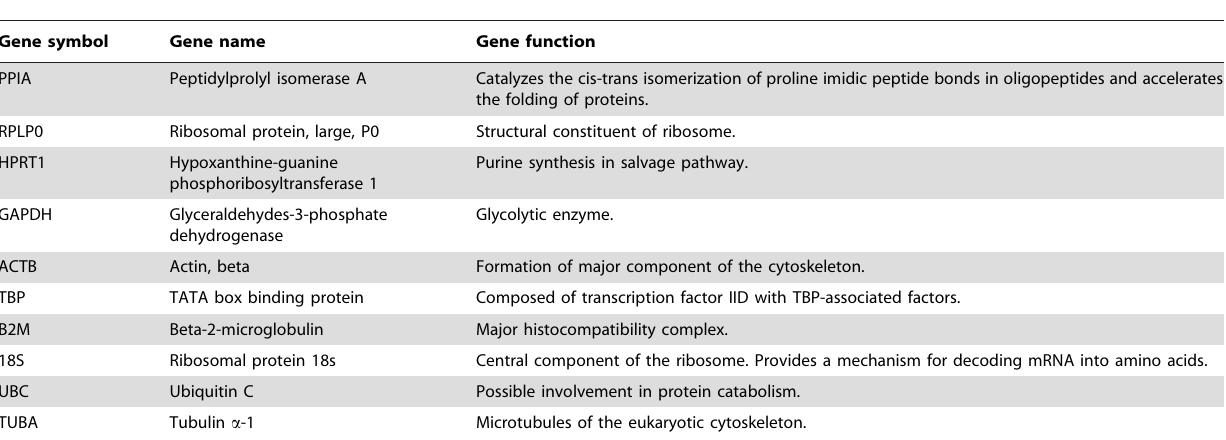
Table 1. Summary of candidate reference genes used in this study.